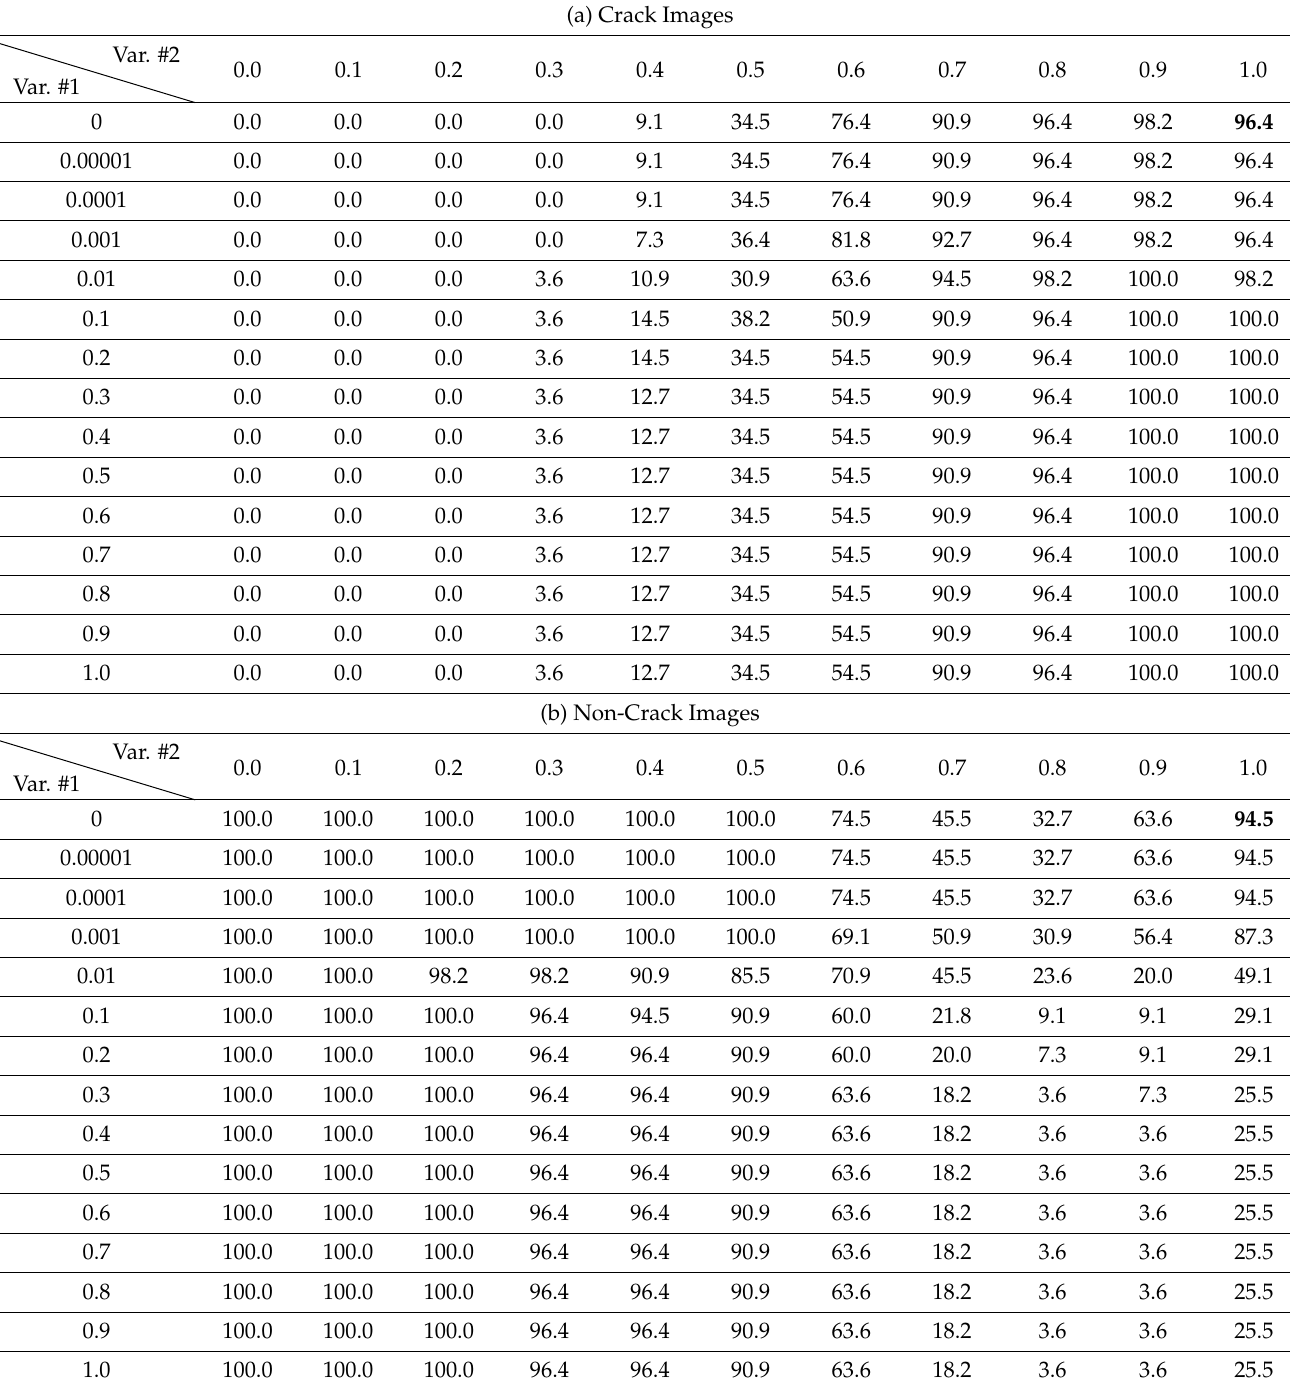
Table 6. Analysis results (%) by Var. #1 vs. Var. #2 (Var. #3: Gaussian). (a) Crack